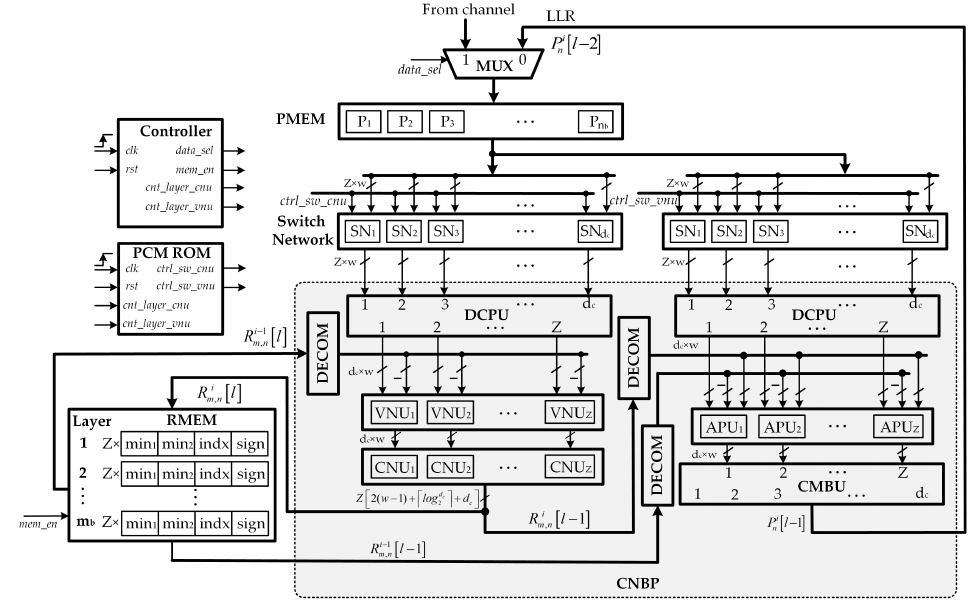
Figure 4. Proposed overall low-complexity high-throughput pipelined layered QC-LDPC decoder